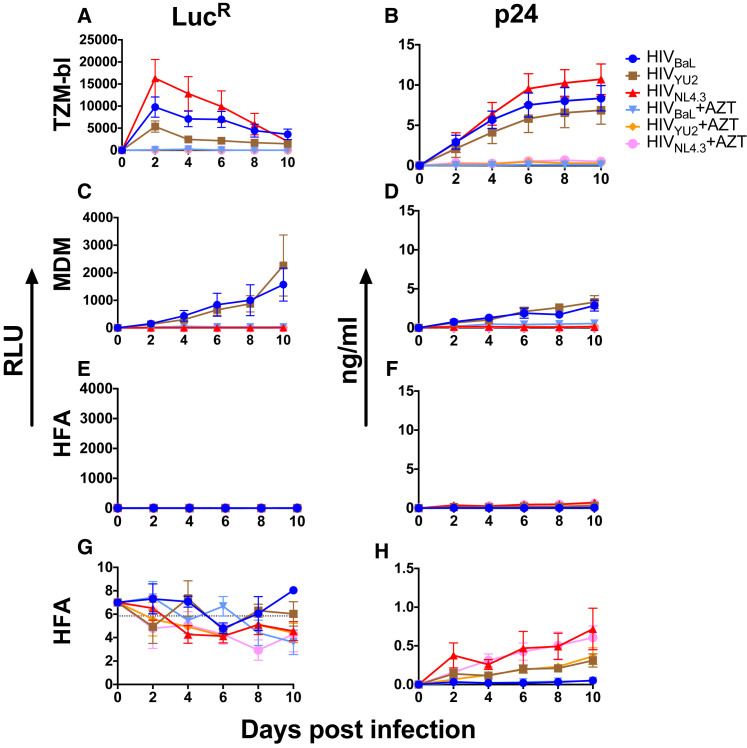
HFAs Are Not Productively Infected by HIV-1 but Trap and Release Viral Gag(A–H) TZM-bl cells (A, B), MDMs (C, D), and HFAs (E–H) were incubated overnight with or without AZT with HIV-1 luciferase reporter viruses at MOI = 0.1, washed, and cultured with or without AZT. At the times shown, cells were lysed and assayed for luciferase activity (A, C, E, and G) or supernatants were harvested and assayed for Gag p24 by ELISA (B, D, F, and H). (G) and (H) represent (E) and (F), respectively, with expanded scales. The dotted line in (G) shows the background luciferase signal obtained with uninfected HFAs. Data represent means of three to five independent experiments ± SD using five MDM donors.